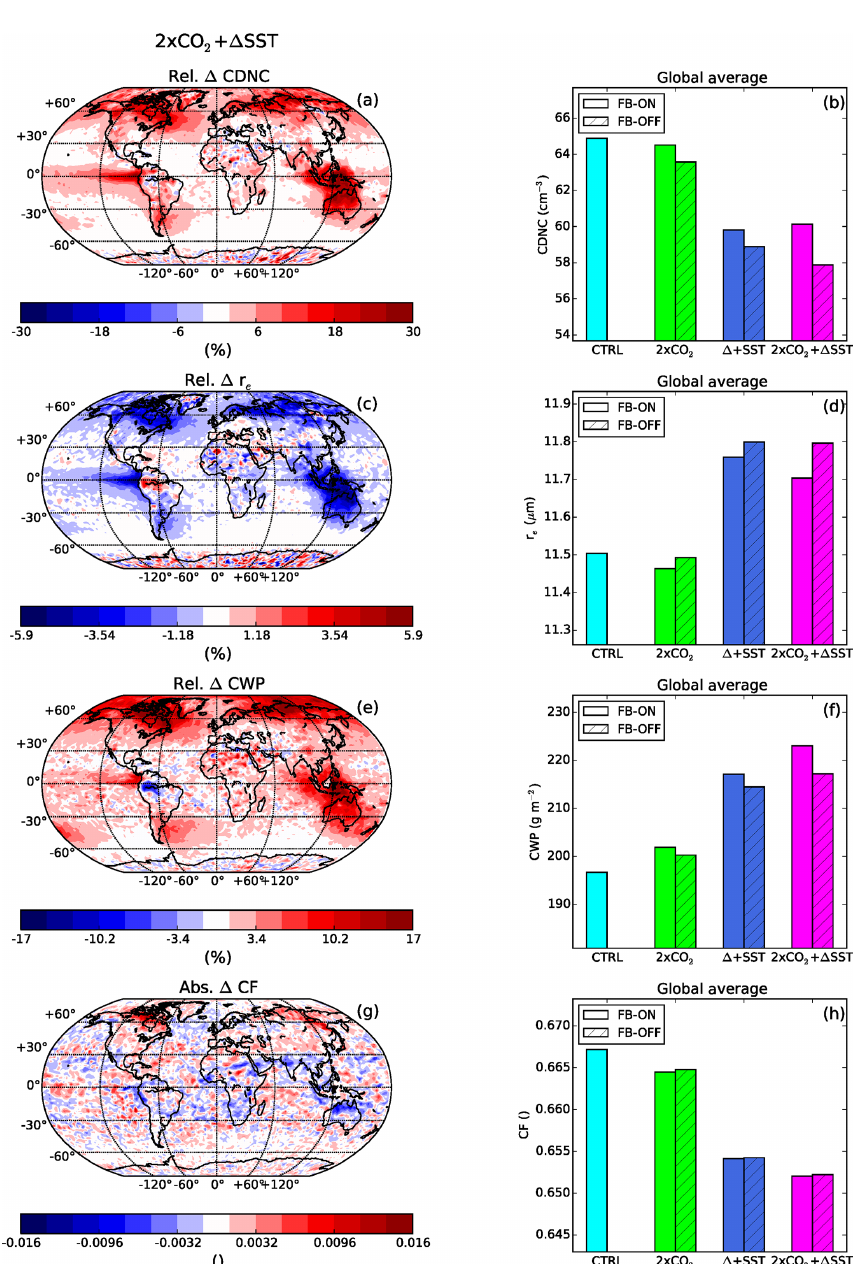
Figure 7. The relative/absolute difference between the FB-ON and FB-OFF simulations in the annual vertically averaged CDNC (a) , the vertically averaged r e (c) , the CWP (e) and the total CF (g) for the 2 × CO 2 + (cid:49) SST experiment. In the bar plots (b, d, f, h) , the globally averaged values of the same variables are shown for the CTRL simulation as well as the three experiments (both FB-ON and FB-OFF simulations). For the CDNC, r e and CWP, the in-cloud values are